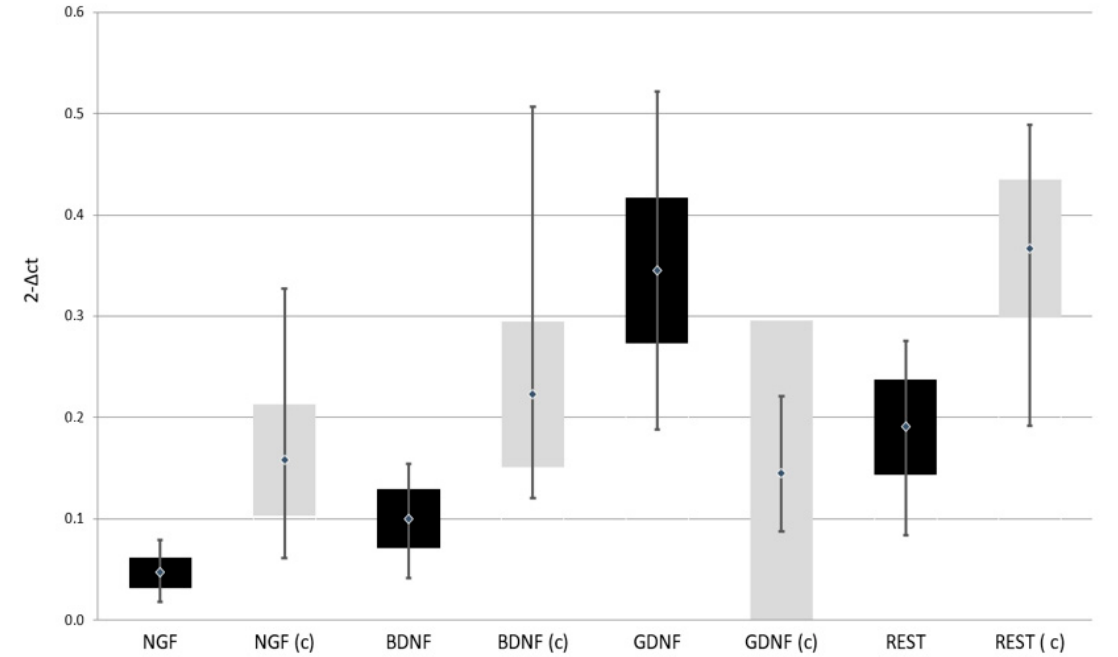
Figure 2. Expression of selected genes regulating the process of neurogenesis at mRNA level in the study and the control group; black—study group; light gray (c)—control group; NGF—Nerve Growth Factor; BDNF—Brain-Derived Neurotrophic Factor; GDNF—Glial-Derived Neurotrophic Factor; REST—RE1-Silencing Transcription factor.